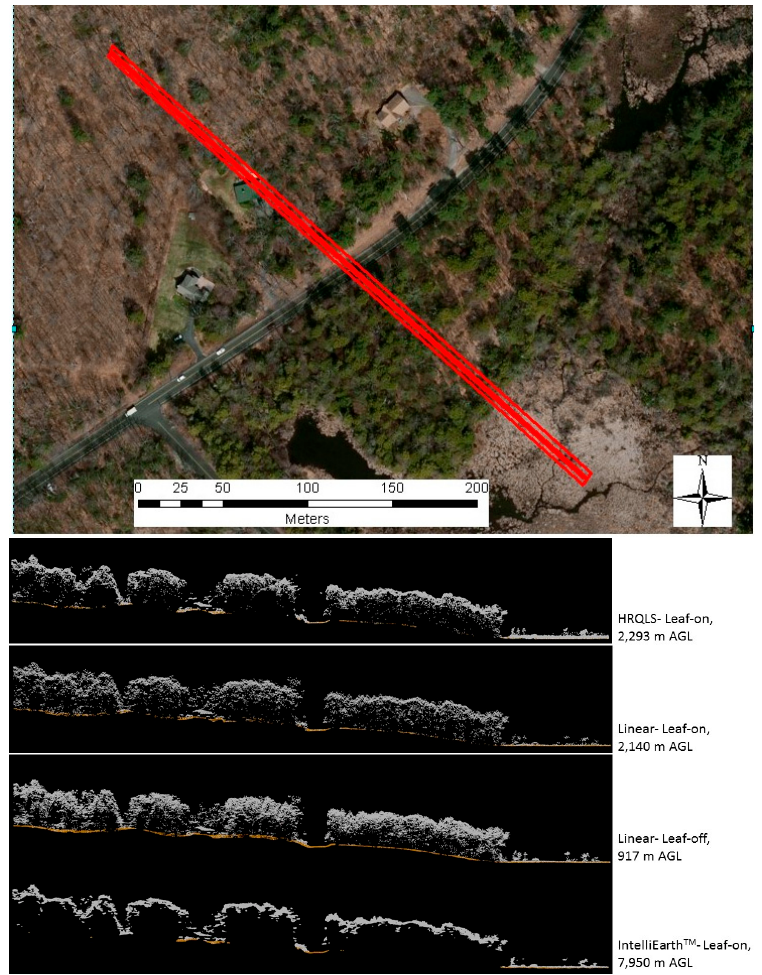
Figure 5. Cross section used for comparisons, overlaid on imagery ( image top ). Sample profiles of HRQLS, leaf on ( top profile ); linear-mode lidar, leaf-on ( middle-top profile ); linear-mode lidar, leaf-off; ( middle-bottom profile ); and IntelliEarth TM lidar, leaf on ( bottom profile ).